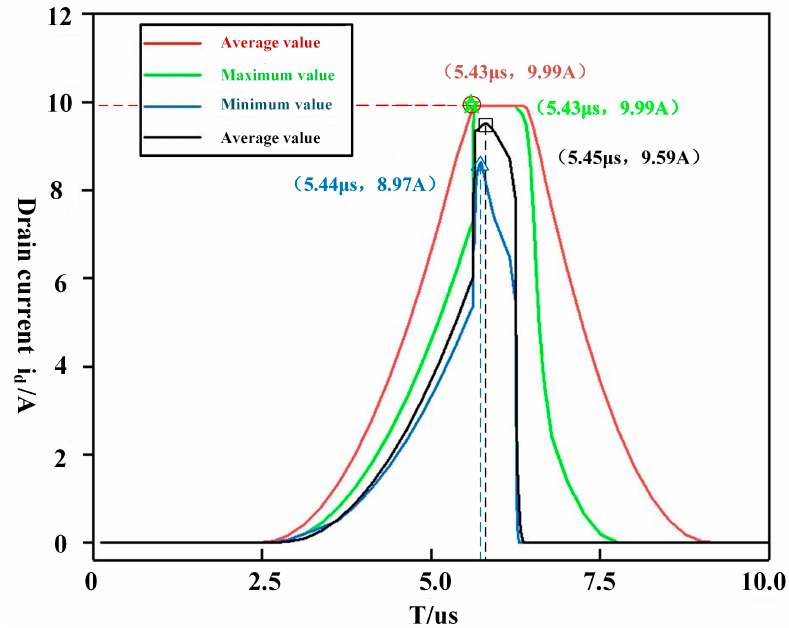
Figure 10. Simulation curves of id and the maximum value, standard value, average value, and minimum value of L s